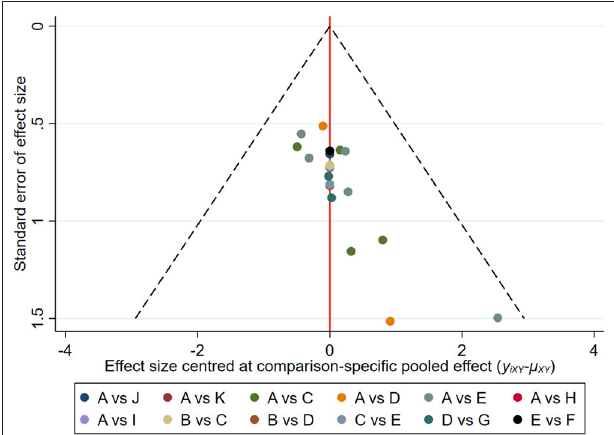
FIGURE 7 | Comparison-adjusted funnel plots for the CER network. The vertical axis represents “standard error of effect size” and the horizontal axis represents “effect size centered at the comparison-specific pooled effect (y ixy − u xy ).” (A, CT; B, CT + Drug; C, CT + MA; D, CT + EA; E, CT + MOX; F, CT + WNM; G, CT + EA + MOX; H, CT + AA; I, CT + AP; J, CT + MOX + DSQP; K, CT + WAA + MOX; L, CT + multiple acupuncture).